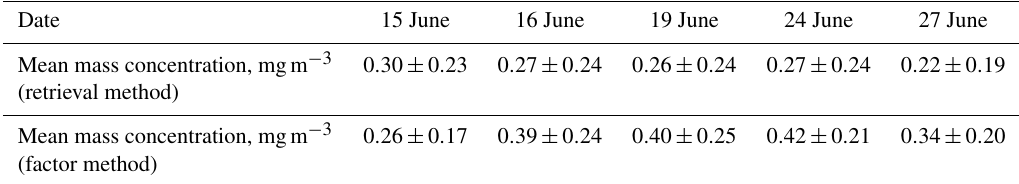
Table 2. Mean dust mass concentration of each cross-sections at different times during the dust transport calculated by two methods.